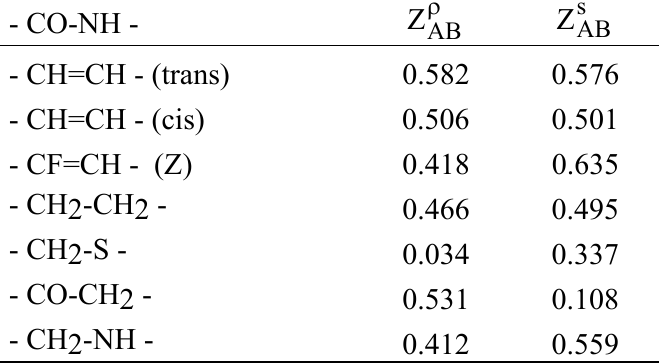
Table 2 : Similarity indices Z 311G* calculation). The centers of the central bond were brought to